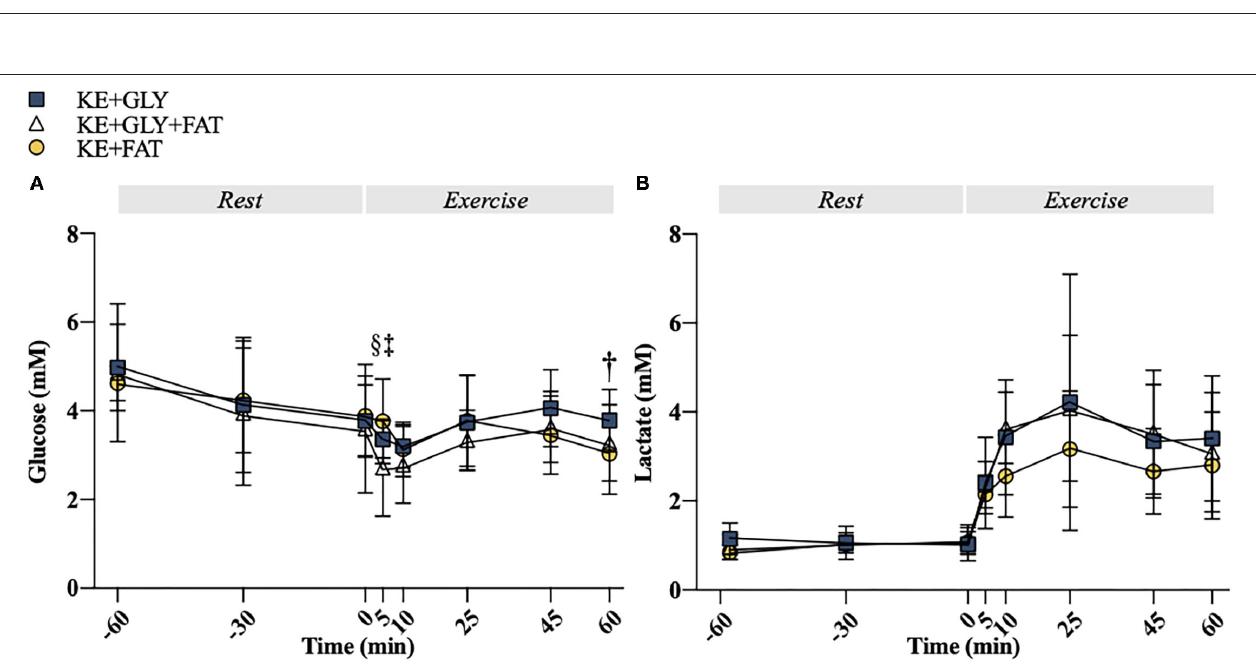
FIGURE 5 | Plasma metabolites. (A) Plasma glucose at rest and during exercise. (B) Plasma lactate at rest and during exercise. Significant post-hoc comparisons: † = KE + CHO vs. KE + FAT; ‡ = KE + CHO + FAT vs. KE + FAT; § = KE + CHO vs. KE + CHO + FAT. Values = mean ± SD.